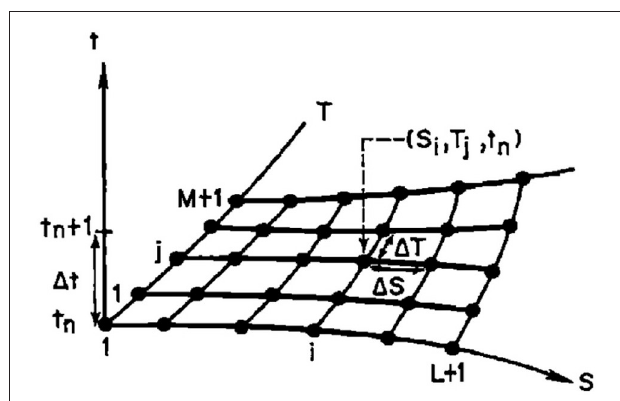
FIGURE A1 | Principal directions co-ordinates and space-time computational grid. Reprinted from Syriopoulou and Koussis